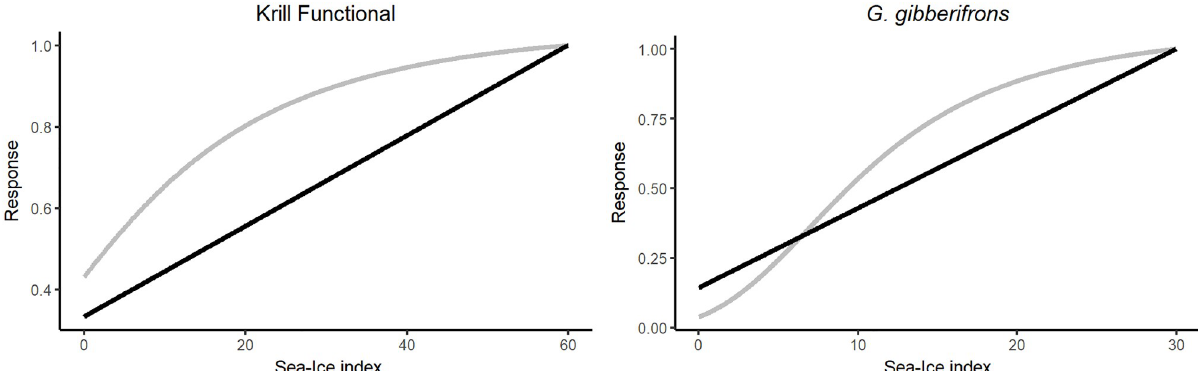
Fig 3. Evaluated functional responses curves. Black lines are the linear curves, grey lines represent the sigmoidal (krill) and normal ( G . gibberifrons ) curves. https://doi.org/10.1371/journal.pone.0214814.g003 decline. The simulations used curves drawn directly in Ecosim (Fig 3): linear curve (start = 0,